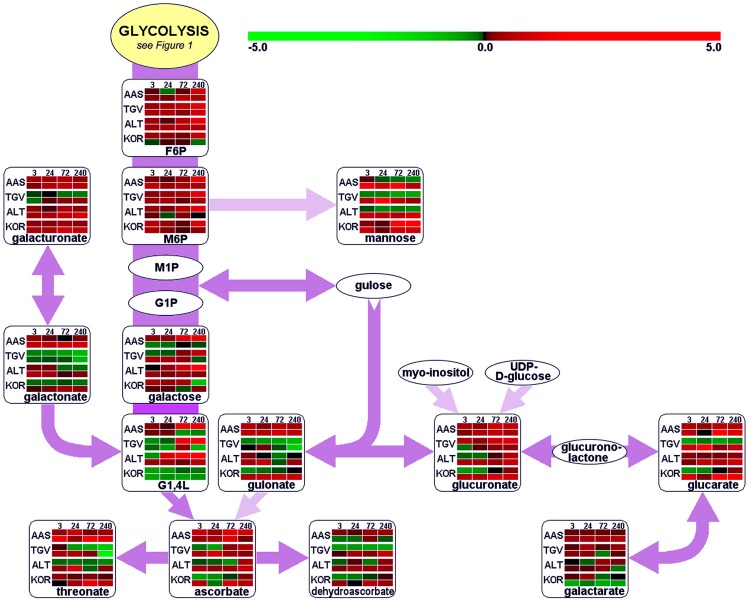
Functional regulation of ascorbate metabolism. For further details about pathway map, experiments and color settings, see Figure 1. F6P, fructose-6-phosphate; G1,4L, galactonic acid-1,4-lactone; G1P, galactose-1-phosphate; M1P, mannose-1-phosphate; M6P, mannose-6-phosphate; UDP, uridine-diphosphate.